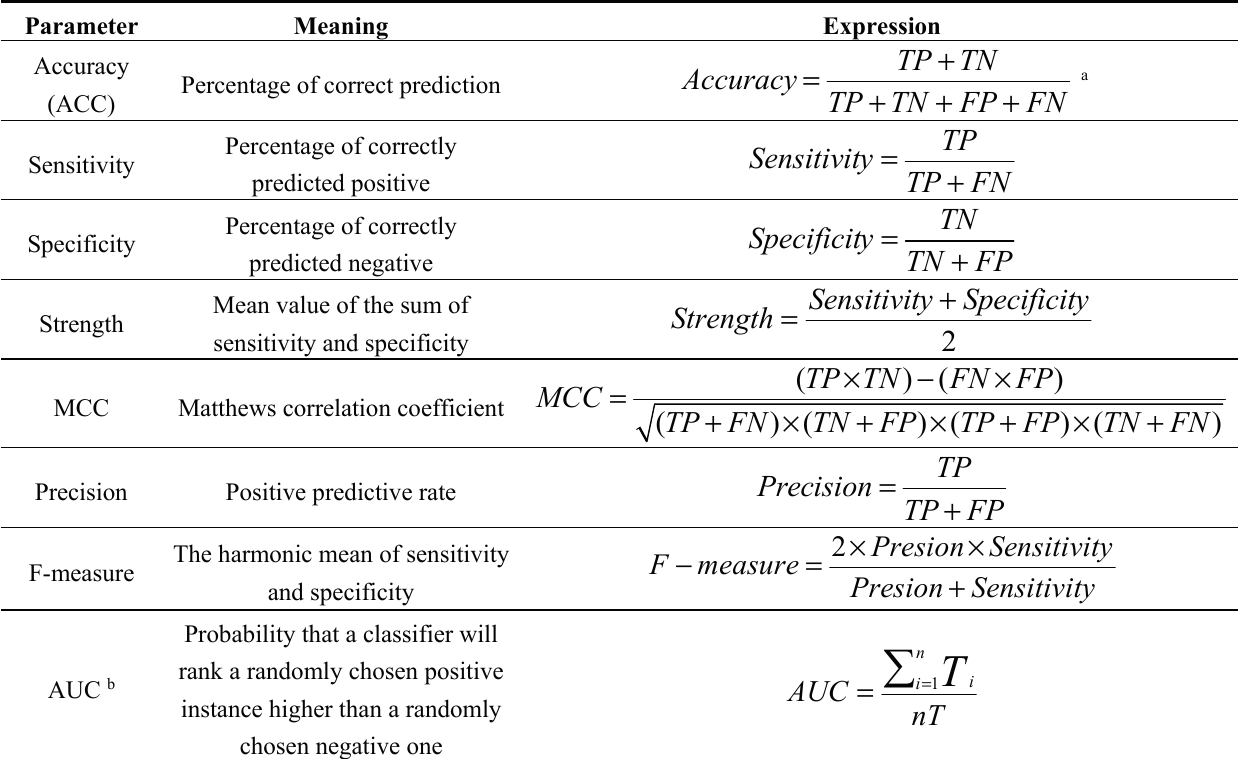
Table 2. Evaluation